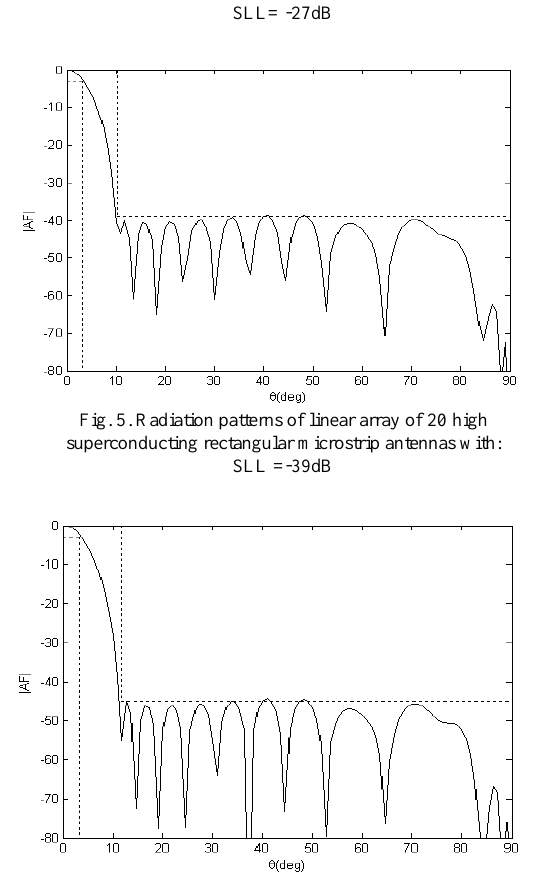
Fig. 6. Radiation patterns of linear array of 20 high superconducting rectangular microstrip antennas